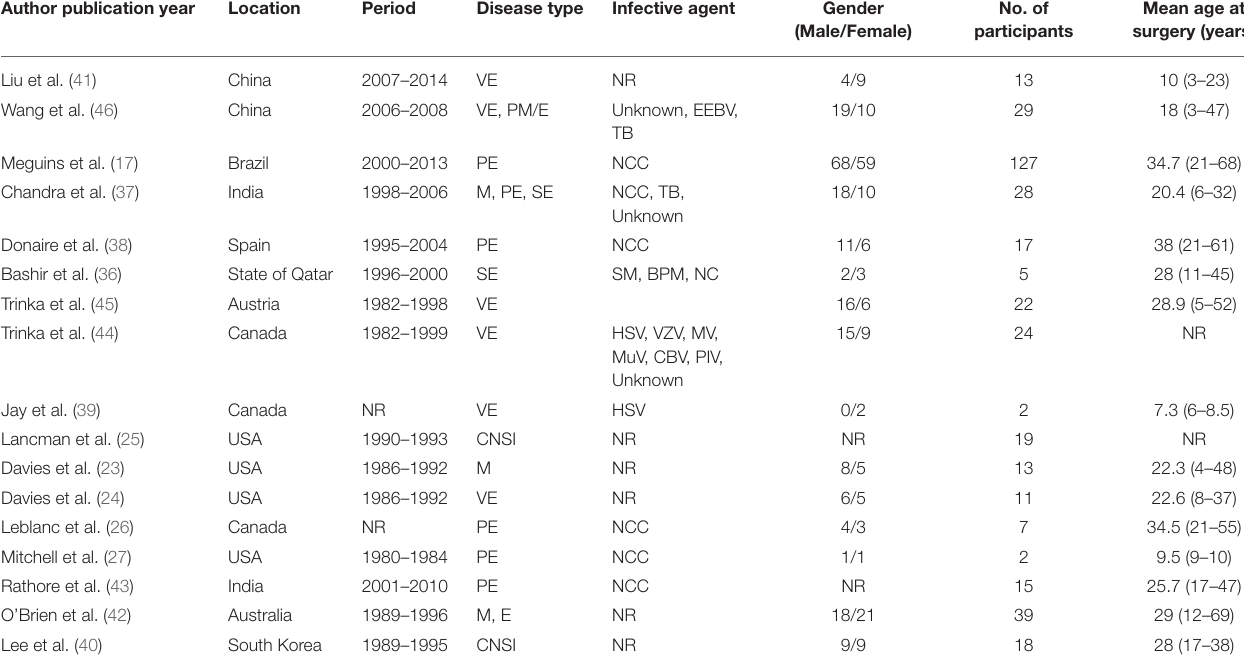
TABLE 1 | Characteristics of the included